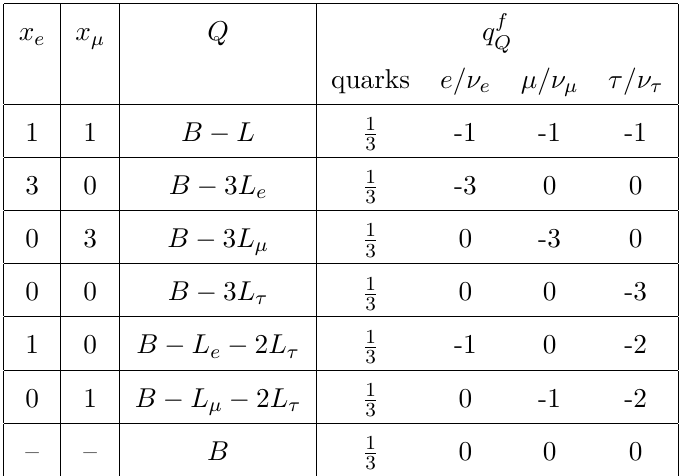
Table 1 . Symmetry generators and fermion charges for the models considered in this